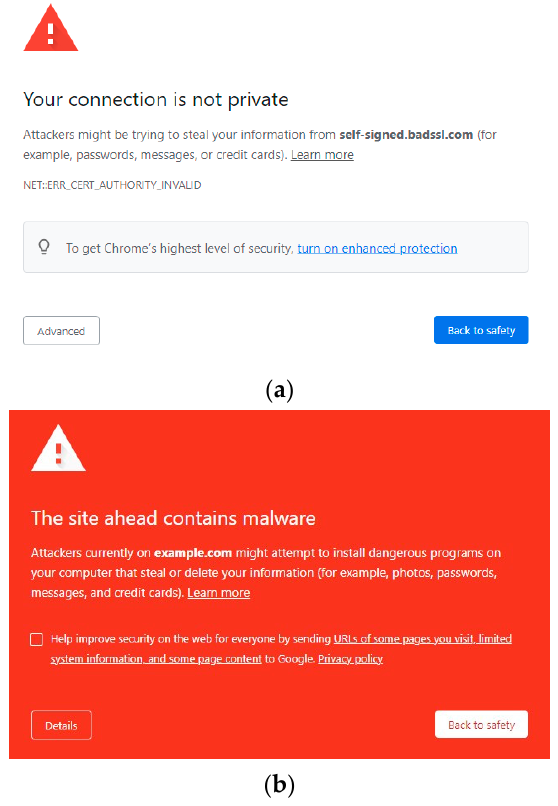
Figure 4. Example of Google Chrome’s warning and blocking pages: ( a ) intermediate warning page for SSL issue [Source: Screenshot from Chrome web browser of BadSSL.com demo site] and ( b ) blocking page for malware website [Source: Screenshot from Chrome web browser].